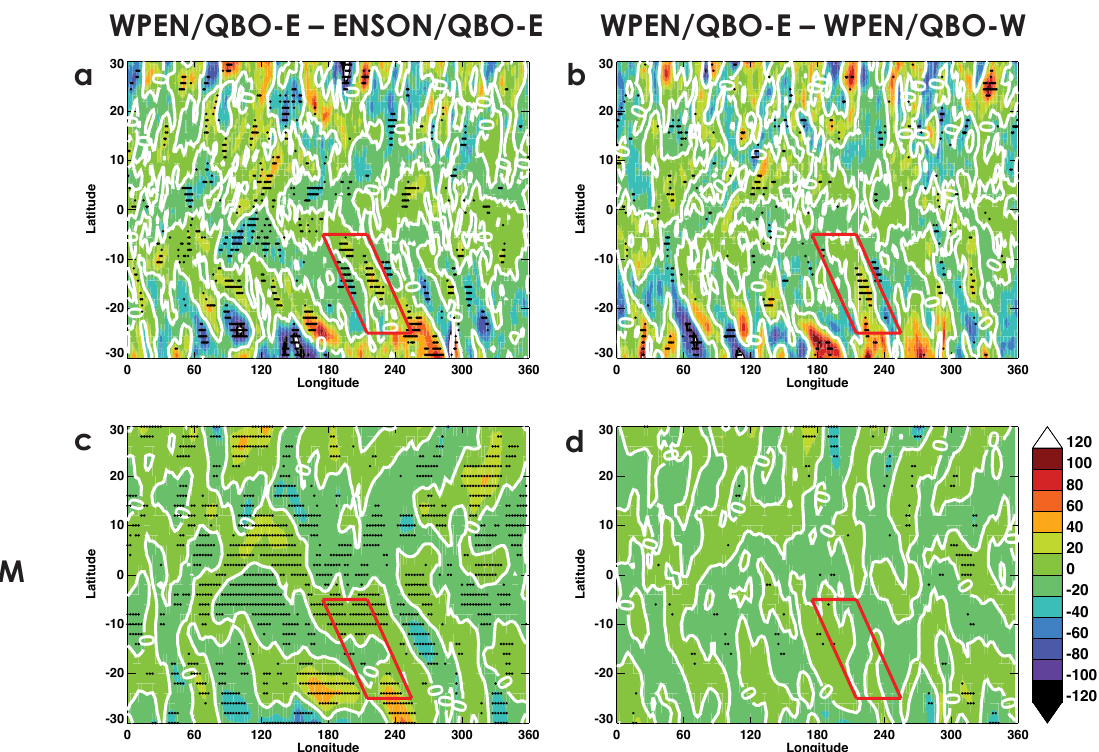
Fig. 7. Longitude-latitude contour plots showing SON seasonal mean differences in the Rossby wave source (10 10 s − 2 ), as described in the text, in (a, b) MERRA and (c, d) the GEOS CCM simulations. The response to WPEN events during QBO-E is shown in (a) and (c) . The response to the QBO phase during WPEN events is shown in (b) and (d) . White contours indicate zero difference. Black Xs indicate regions where differences are significant at the 95% confidence level. Red boxes indicate the approximate Rossby wave source region found by Vera et al.